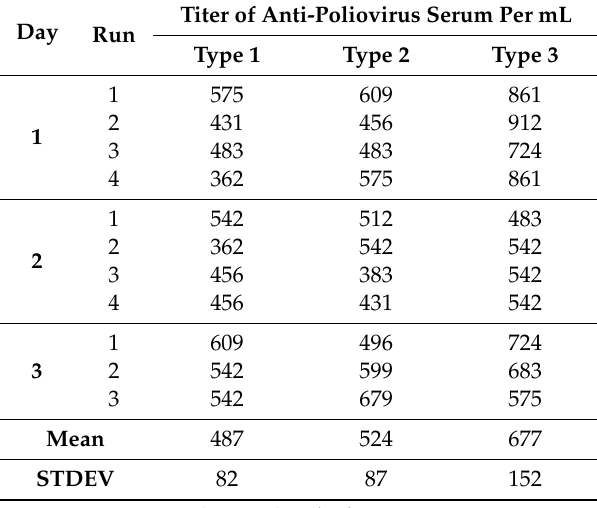
Table 7. Results of consistency evaluation of MPBN assay using anti-poliovirus trivalent